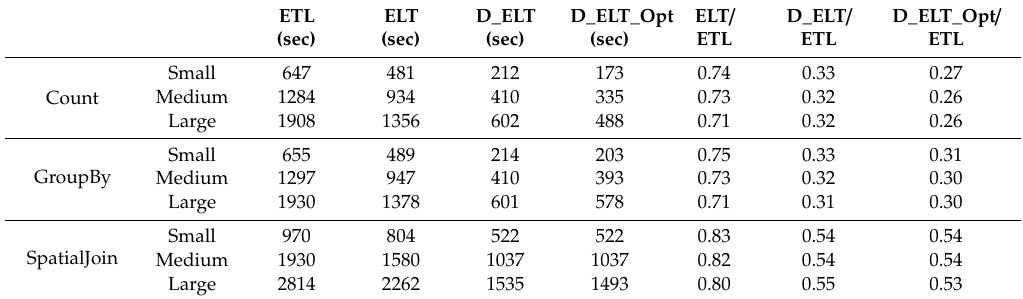
Table 5. Overall performance of ETL, ELT, D_ELT, optimized D_ELT (in seconds), and performance comparison among ELT vs. ETL, D_ELT vs. ETL, and optimized D_ELT vs. ETL.